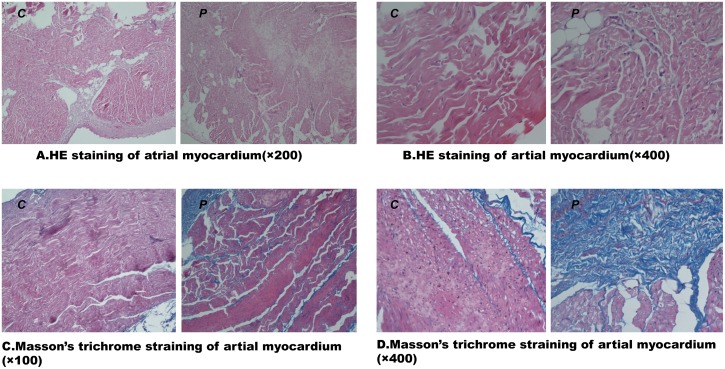
Representative HE staining (up panel) and Masson’s trichrome staining (down panel) of the atrial myocardium.(A) Structurally normal atrial myocardium in the control group and severe fibrosis in the pacing group (×100). (B) Atrial myocardium with HE staining under ×400 light microscopy. (C) A small amount of collagen is visible within the atrial myocardium of the control group, and an increased amount of collagen is visible within the atrial myocardium following pacing (×100). The red areas represent myocytes, and the blue areas represent collagen. (D) Atrial myocardium with Masson’s trichrome staining under ×400 light microscopy. C, control group; P, pacing group. (n = 6 for Group C, n = 9 for Group P).